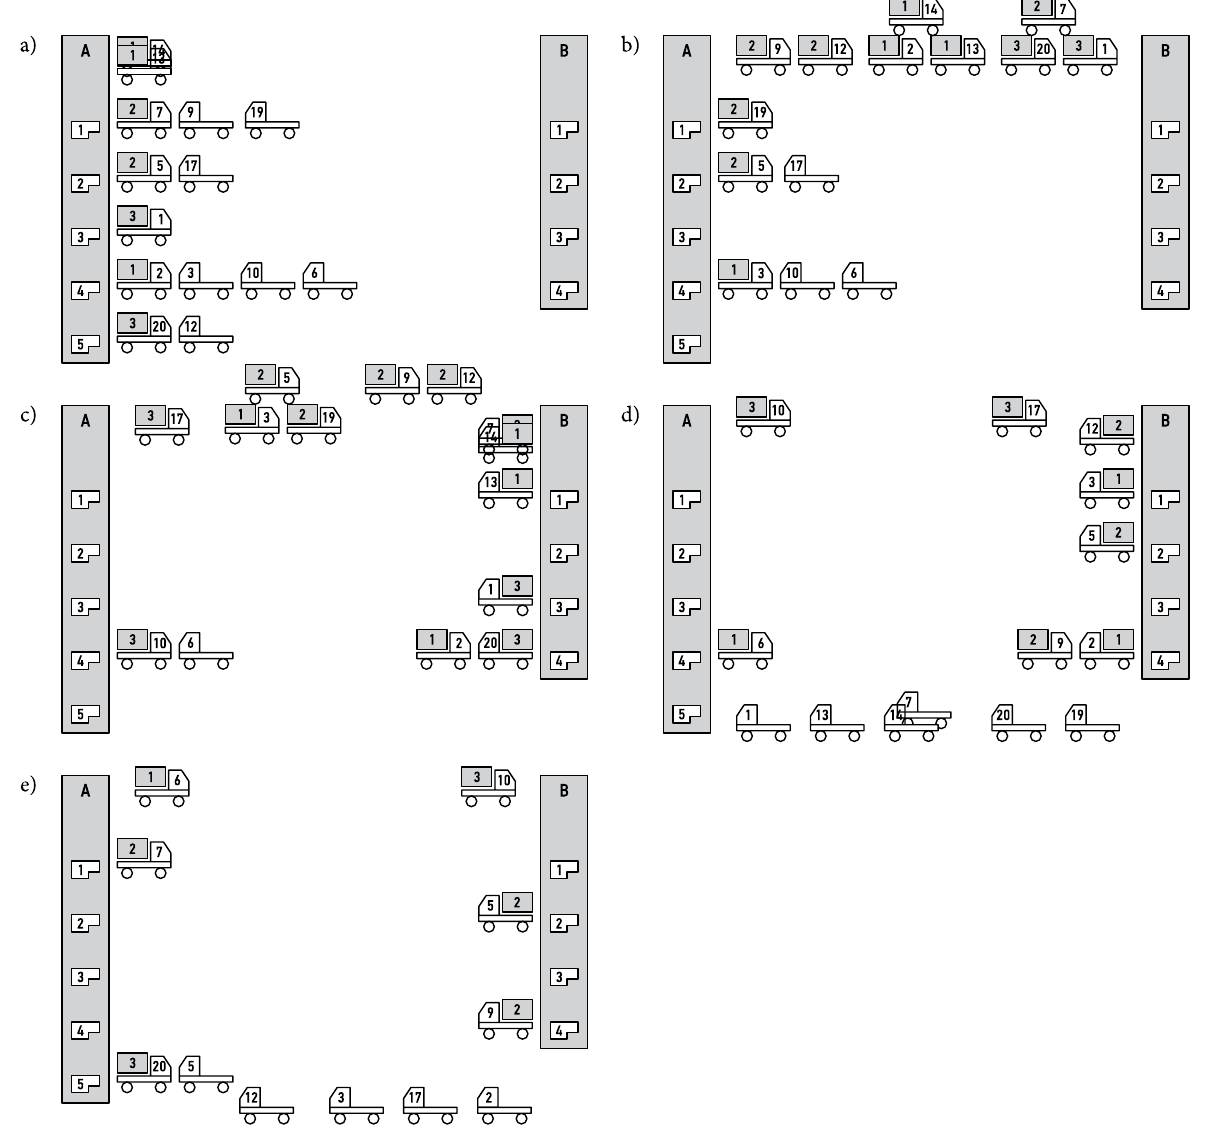
Fig. 4. Free transportation example: a – initial loading at A ; b – moving of loaded vehicles from A to B and loading of queued vehicles; c – unloading of the vehicles at B ; d – returning of the empty vehicles to A and unloading of the remaining at B ; e – loading of the of vehicles in the second